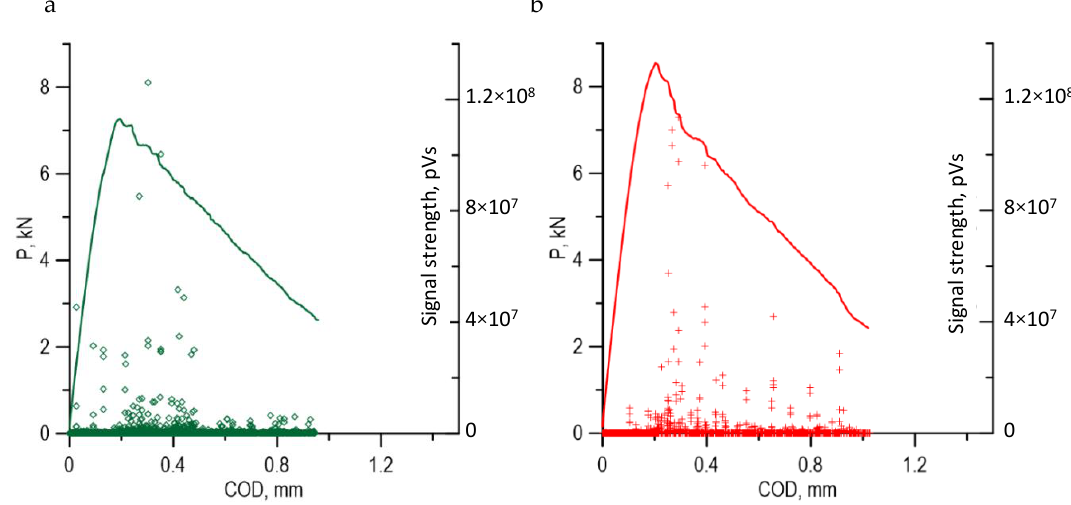
Figure 14. Diagrams of P–COD loading with EA signals for 293 K ( a ) and 223 K ( b ).